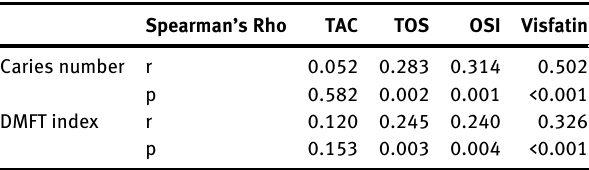
Table  : Correlation analysis of laboratory parameters (visfatin, TAC, TOS, and OSI) and clinical parameters (DMFT index and caries number).